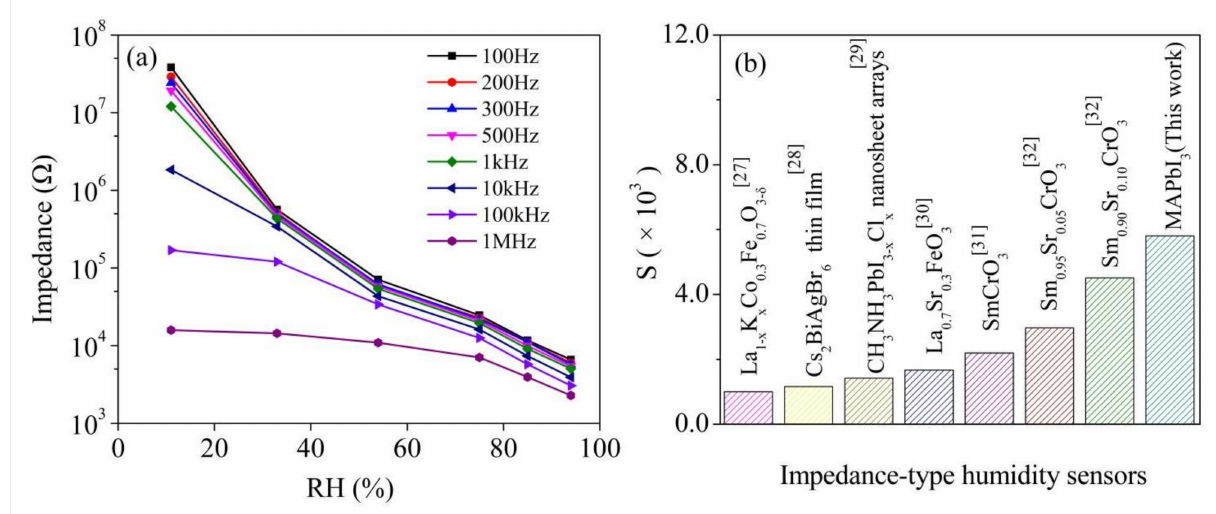
Figure 5. ( a ) The impedance as a function of RH level of the MAPbI 3 -based sensor at different frequencies; ( b ) the contrast between the MAPbI 3 -based sensor and other impedance-type humidity sensors in published